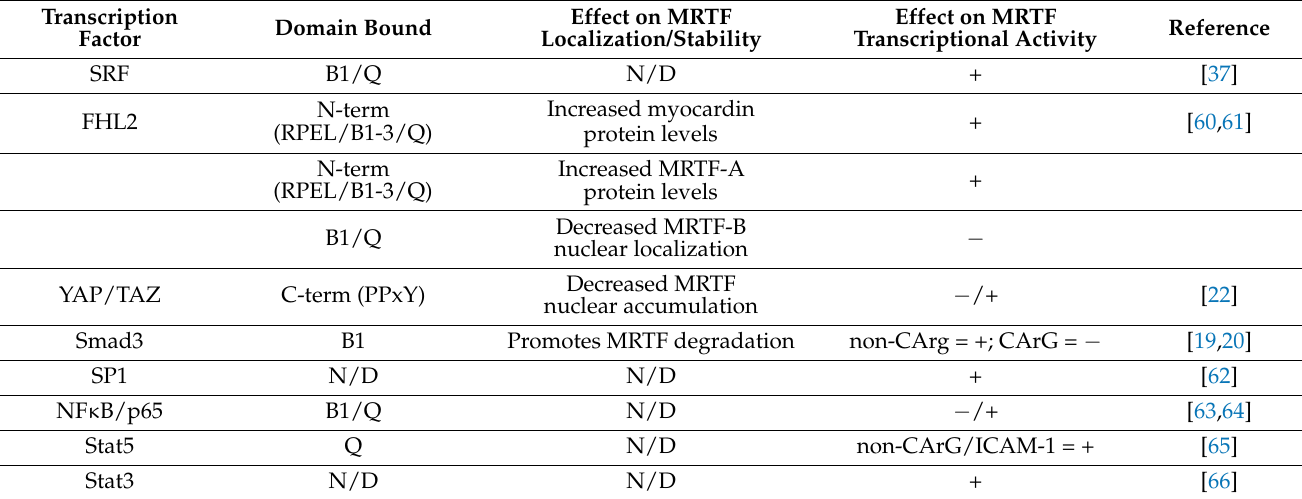
Table 2. Transcription factors and transcriptional co-factors interacting with